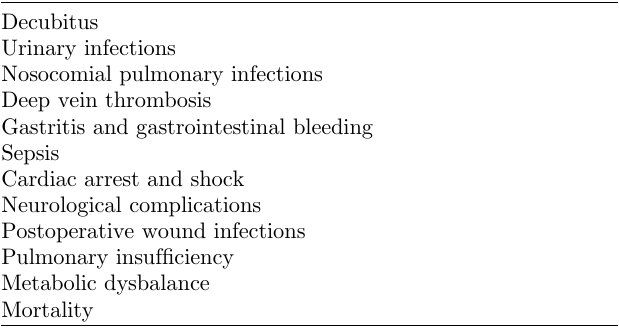
Table 2. Variables for quality results associated with nurse personnel staf fi ng